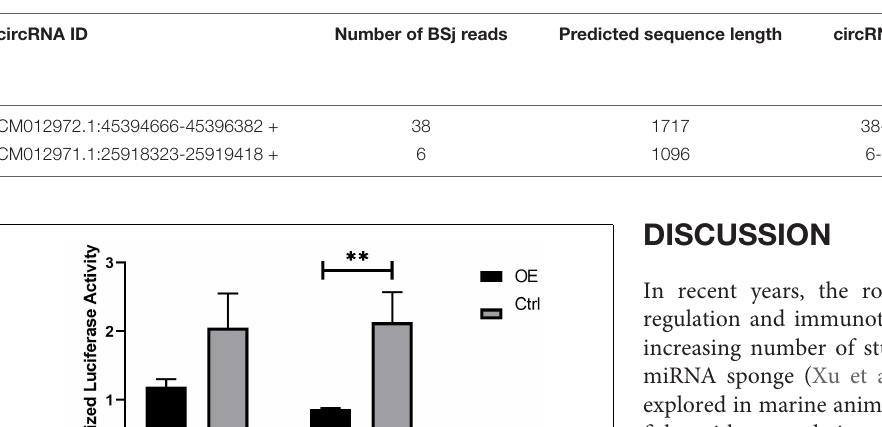
TABLE 4 | Information on the GSTP1-circRNAs.